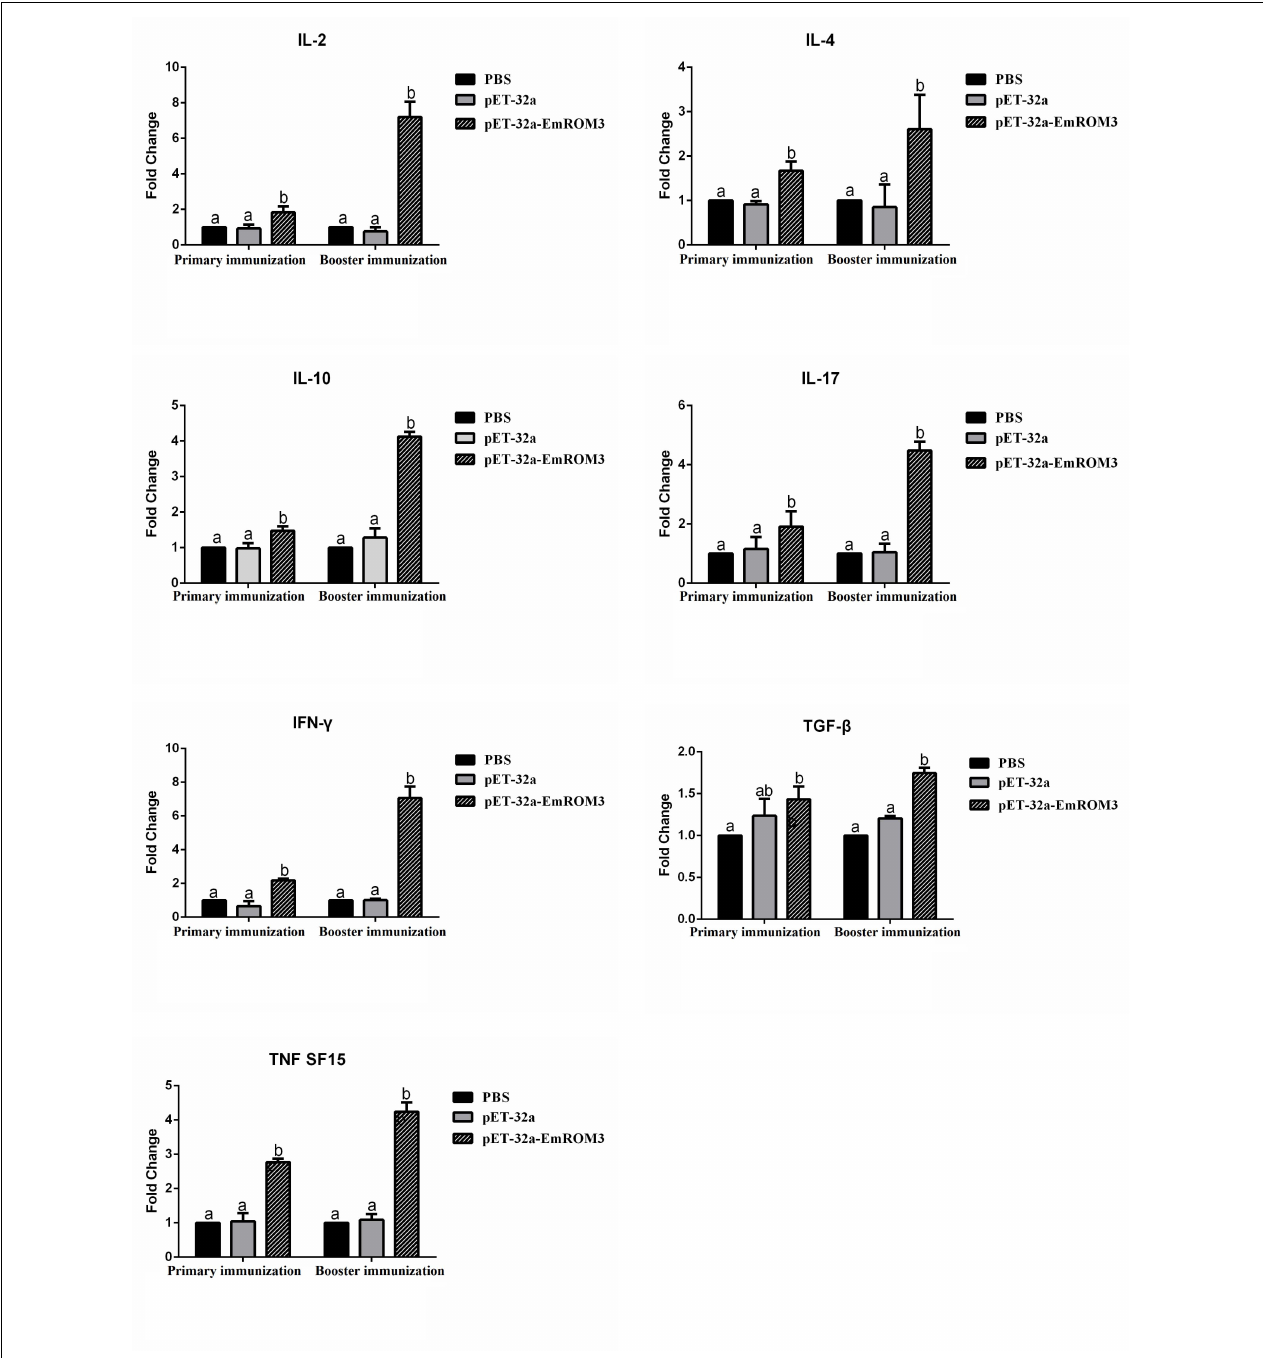
FIGURE 6 | Transcript level of cytokine gene in sera from chickens immunized with recombinant protein pET-32a EmROM3. N = 5, the error bars = standard deviation. Significant difference ( P < 0 . 05) between groups is marked with different letters. No significant difference ( P > 0 . 05) between groups is marked with the same